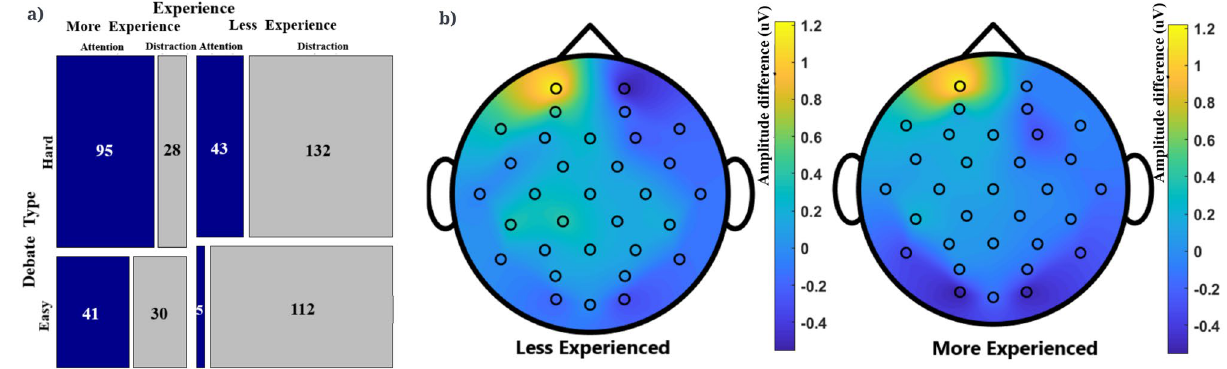
Figure 4. (a) Effect of debate experience on the frequency of occurrence of instances of attention and distraction. (b) Topography maps comparing alpha activity corresponding to the difference (µV) between attention and distraction states for less and more experienced